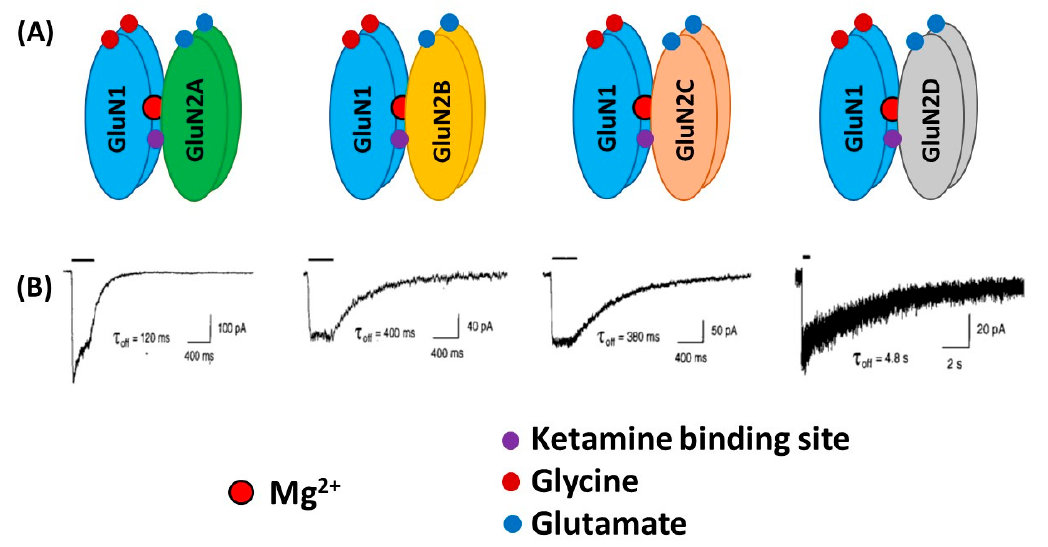
Figure 1. Schematic illustration of the N-Methyl-D-aspartate (NMDA) receptors (NMDARs) containing GluN1 and di ff erent GluN2 subtypes ( A ). Lower traces ( B ) indicate whole-cell patch-clamp recordings of responses from brief application of glutamate (1 ms of 1 mM glutamate) to recombinant diheteromeric NMDA receptor subtypes expressed in HEK293 cells. Averaged o ff set decay constant values ( τ o ff ) are listed below current traces. ( B ) “Reprinted from Neuron, Vol 12, number 3, H. Monyer, N